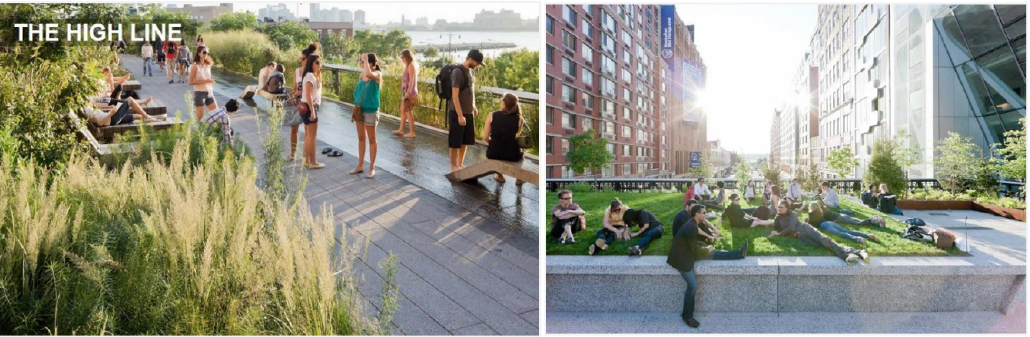
Figure 5. People engagement with nature on the top of the High Line. Data from source [49].